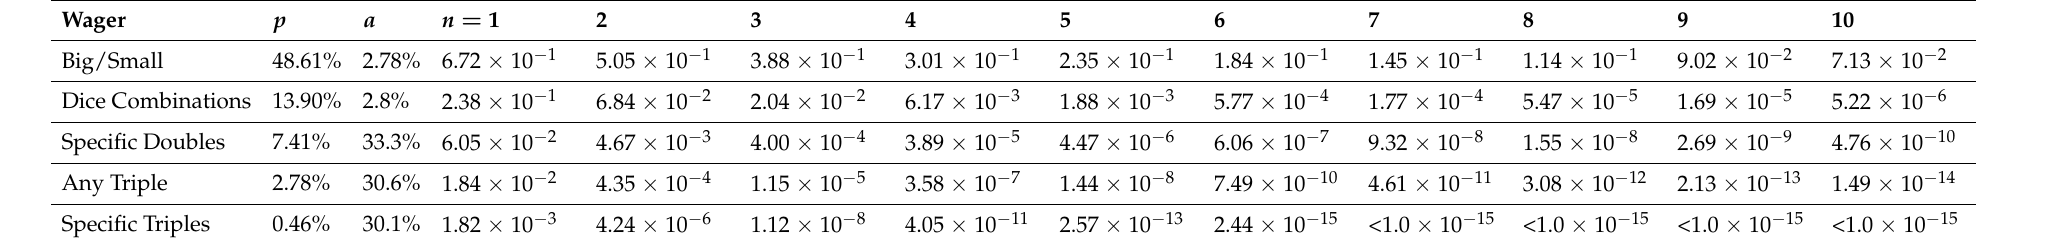
Table 2. The ROR probability obtained by applying the proposed model to each wager of Sic Bo.